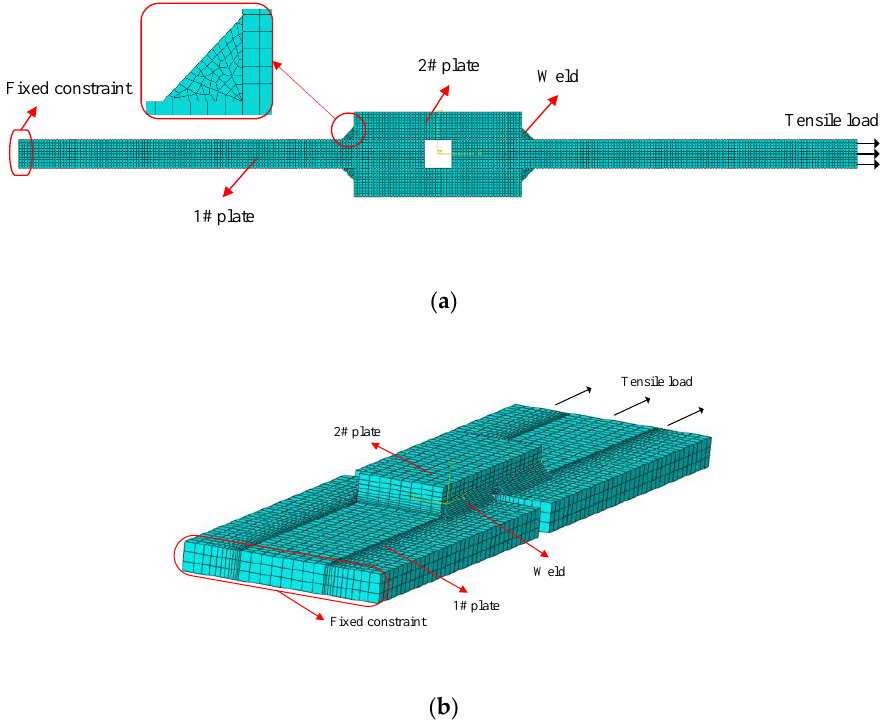
Figure 5. FEM of welded structures: ( a ) transverse welded specimen; ( b ) longitudinal welded specimen. (1# and 2# indicate the plate sequence number).